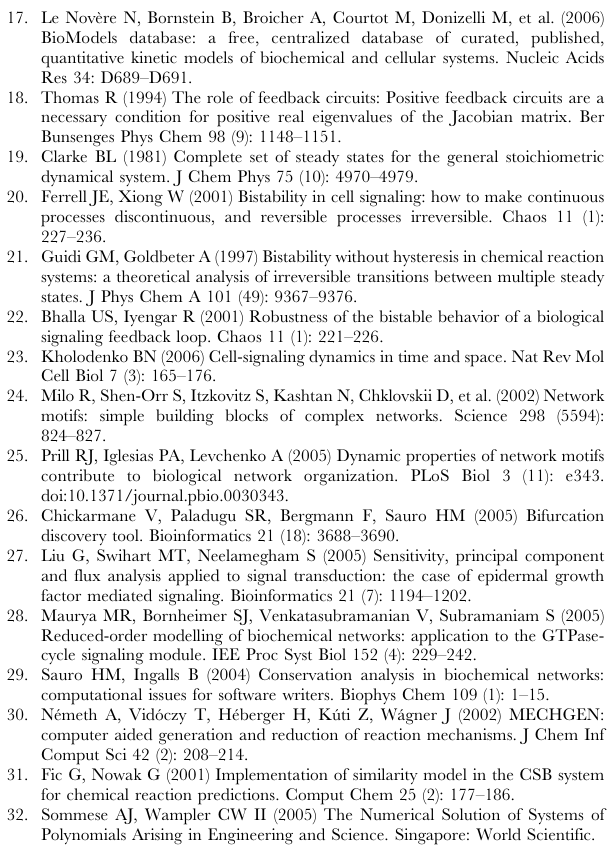
Figure S2. Isomorphic Mappings. (A) Table of Isomorphic Mappings from the Original 12-Reaction Set to a Minimal Set Consisting of Reactions A and E. Note that many mappings require the formation of intermediate molecular species and that enzyme reactions become bidirectional during the expansion. (B) An example of an isomorphic mapping where bistability is preserved, despite the change from unidirectional enzyme to two bidirectional conversion reactions. (C,D) Examples of isomorphic mappings that lose bistability. In both cases, the bistability is lost because the expanded form of an enzyme contains two bidirectional reactions, which can also be mapped to an enzyme with the reverse direction. Found at: doi:10.1371/journal.pcbi.1000122.s003 (0.24 MB